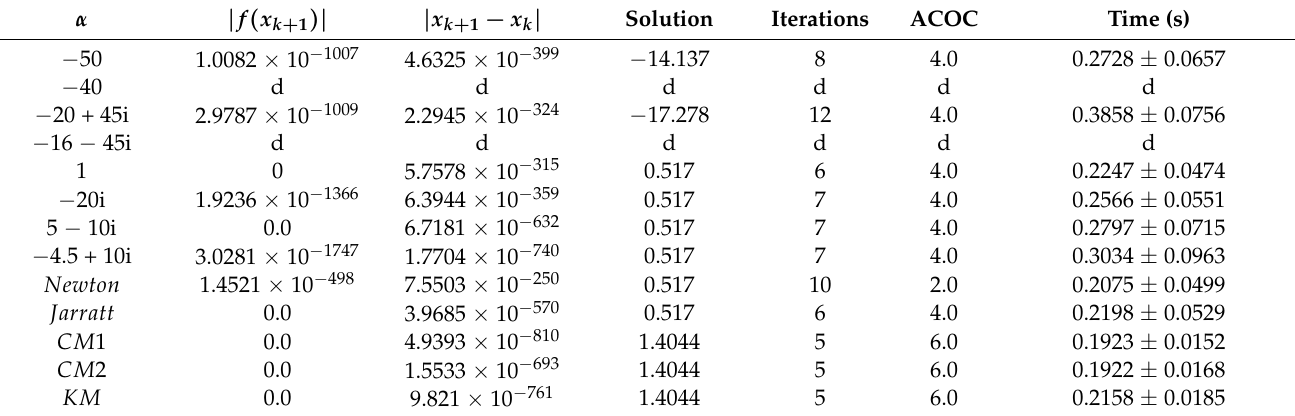
Table 3. f 2 ( x ) = cosx − xe x , x 0 = 1.